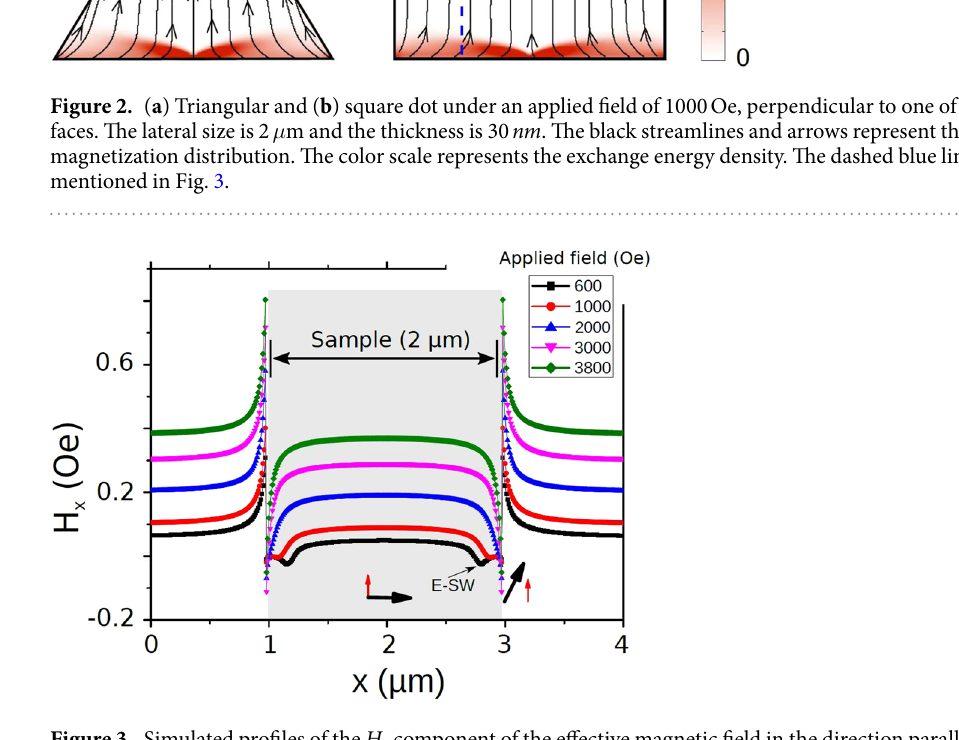
related energy so that mainly inner strip SWs are excited above some critical field 24, 25 . The internal magnetic field profiles for rectangular elements are shown in Fig. 3. In contrast to those studies, E-SWs in the triangular dots can be excited using a parallel pumping scheme (with homogeneous driving microwave magnetic field being parallel to the field H DC ) 26 to avoid excitation of the quasi-uniform mode inside the device. Another important differentiating factor is that, as we shall see below, for triangular dots the edge modes could be excited locally, close to the dot edge, facilitating their propagation along the edges. Indeed, as shown by the dashed lines (cross sections in Fig. 1c), under a DC field parallel to one of their sides, the internal magnetic field distribution has minima near the dot edges which should provide localization of SW at the dot edges. The magnetization dynamics is described by the Landau–Lifshits–Gilbert (LLG) equation of motion governed by an effective magnetic field. SW guidance along E-DWs occurs because the effective field ( H eff ) is formed by both the external and the internal magnetic fields, with the latter generated by the volume and surface magnetic charges. So, increasing the properly aligned DC bias field under excitation localised near vertices just further confines the E-SWs towards the dot edges allowing a continuous field tuning of the E-SW frequency without breaking the SW topology. Our paper presents studies of two related cases: triangular dots in the so-called B state (the bias magnetic field is parallel to the triangle base) and the rectangular dots in the inclined external magnetic field.